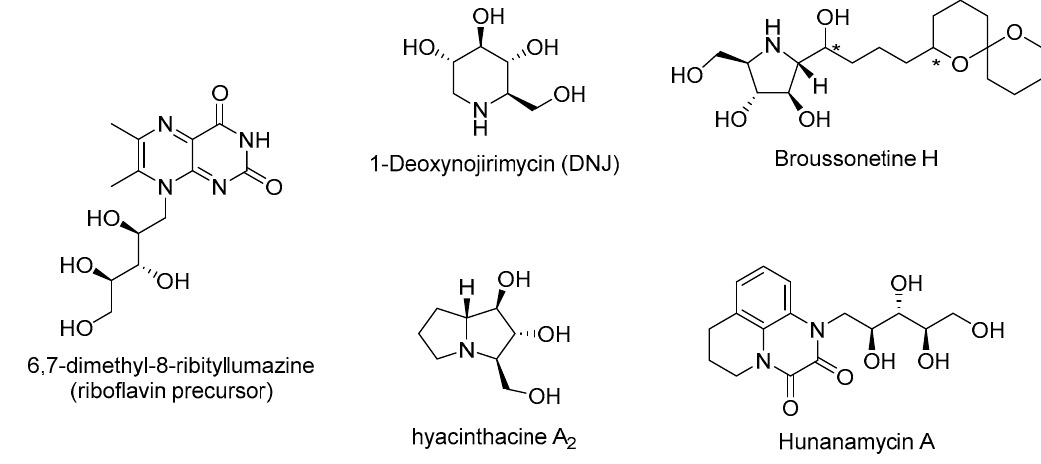
Figure 1. Representative small molecule polyhydroxylated natural products.